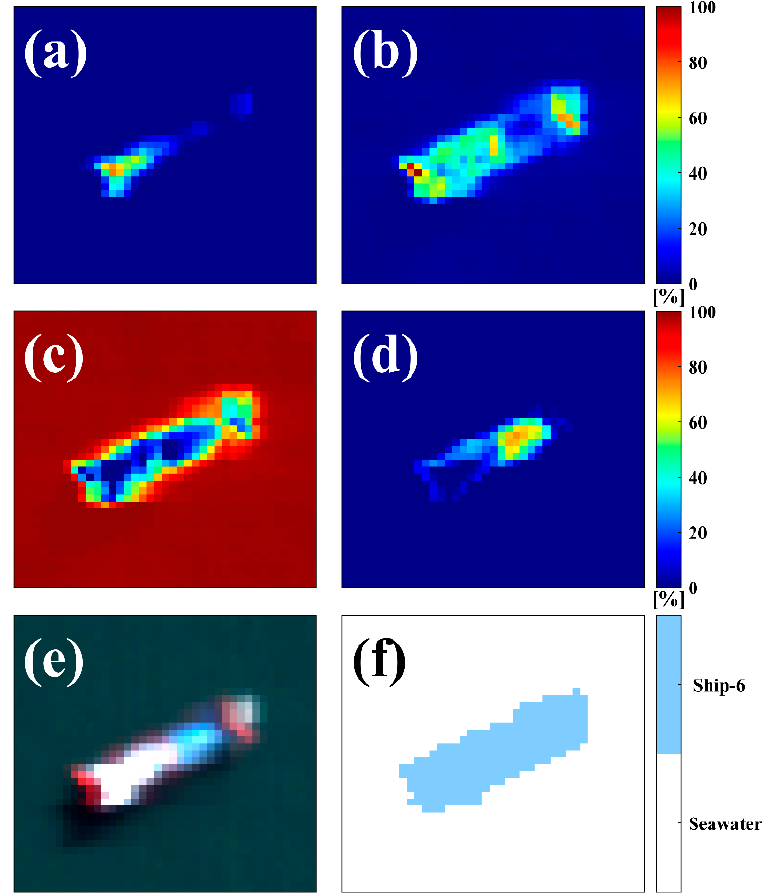
Figure 8. Abundance fraction map ( a – d ) corresponding to endmembers 1–4, and ( e ) RGB composite image. ( f ) Spatial distribution of the classification result for the S 6 vessel based on the abundance fraction of the seawater endmember.